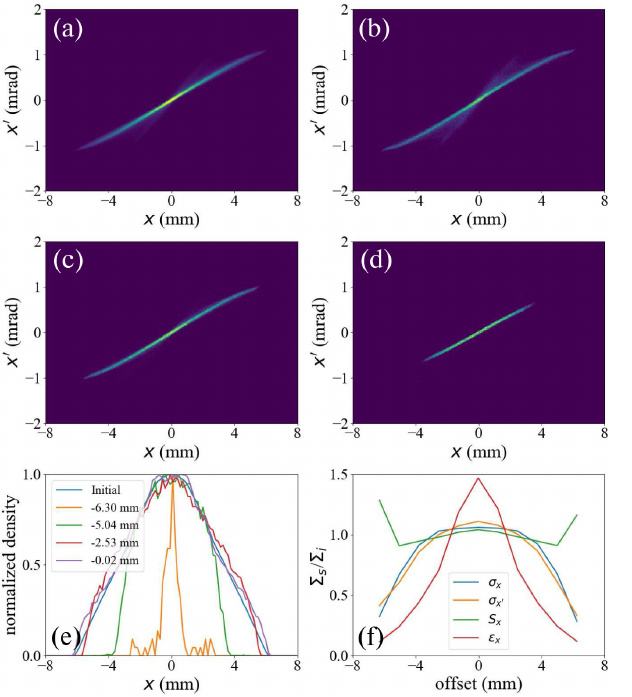
FIG. 6. (a) Horizontal phase space from start-to-end simulation. Image is taken before the horizontal slit. (b) Horizontal phase space after the slit. Here, the slit opening is located at the vertical center of the beam. (c) Horizontal phase space after the slit that is located at y ¼ − 2 . 53 mm. (d) Horizontal phase space after the slit that is located at y ¼ − 5 . 04 mm. (e) Comparison of hori- zontal profiles before the slit (blue) with profiles after slits located in different vertical positions. (f) Ratios of second moments before and after the slit with different vertical positions. Offset means the distance between the center of the slit and the vertical center of the beam.